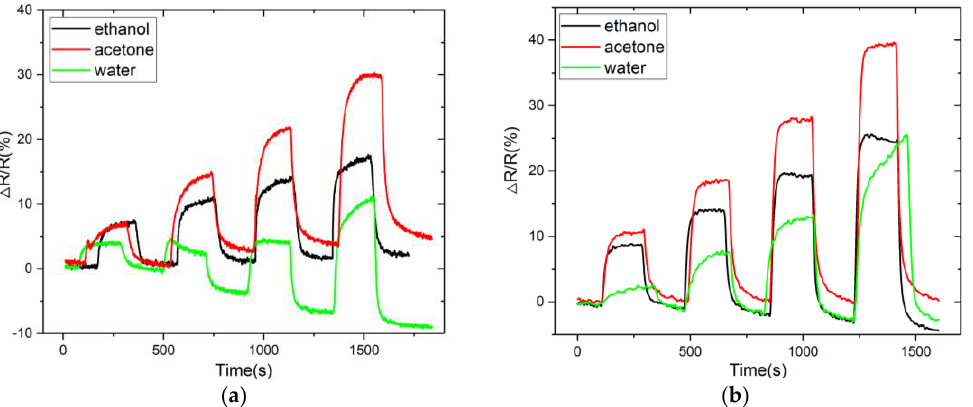
Figure 7. Sensor responses for various sensitive layer and vapors. The vapors corresponding to the figures are ( a ) acetone; ( b ) ethanol.